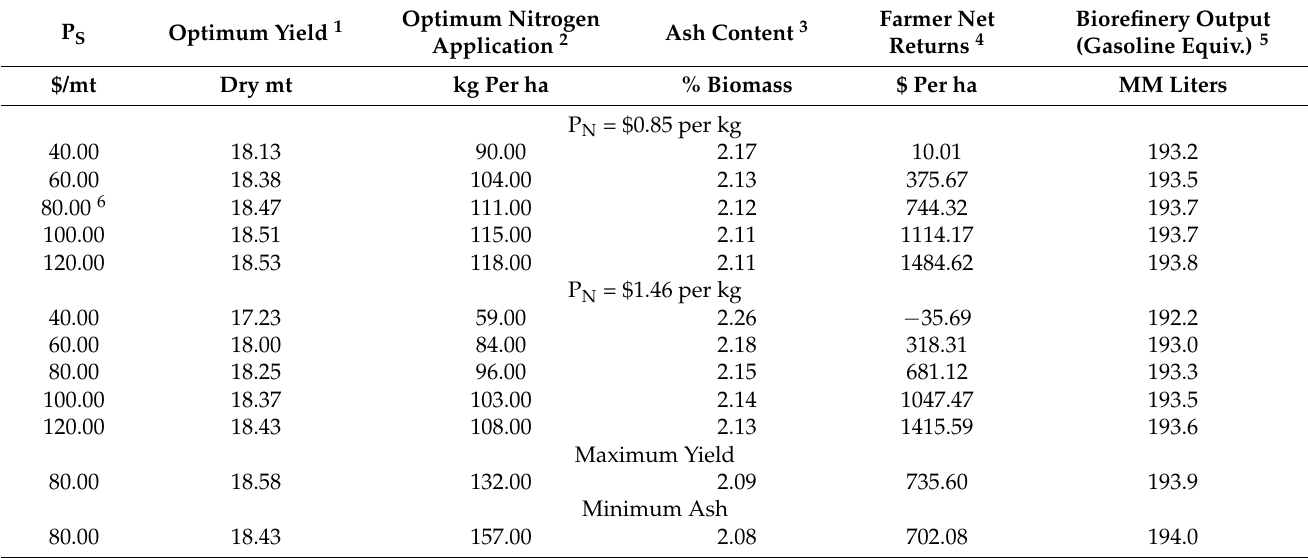
Table 6. Estimates of optimum levels of biomass yield and corresponding biorefinery output as price of feedstock varies between 40 and 120 dollars per dry metric ton (P S ) and two levels of N price (P N ) ($0.85 and $1.46 per kg), considering ash, moisture, and carbon content in Alamo switchgrass.